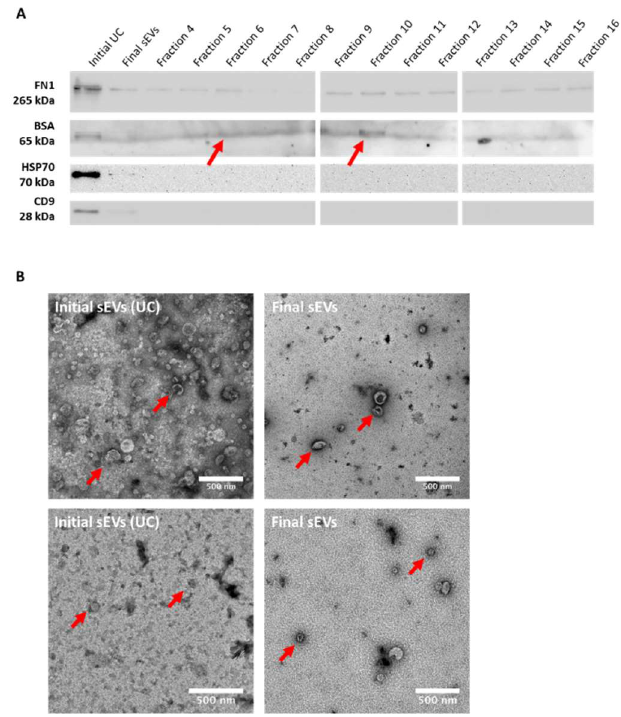
Figure 3. Validation of sEV concentration and decreased protein contamination. ( A ) Western blotting detection of fibronectin (FN1), bovine serum albumin (BSA), HSP70 and CD9 in initial (UC), final sEVs and SEC fractions. ( B ) TEM detection of sEVs ( × 20k magnification and zoom). Red arrows show sEVs. Representative pictures are shown. Scale bar = 500 µm.